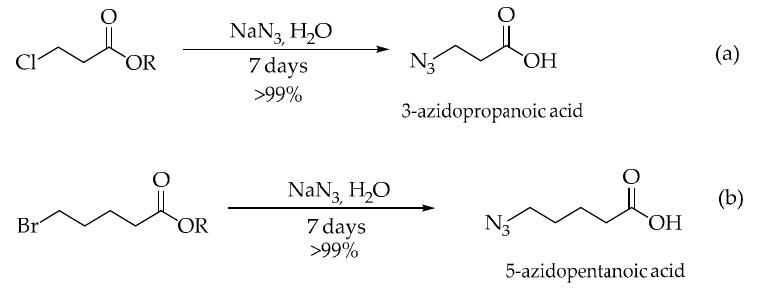
Figure 5. The synthesis of 3-azidopropanonic ( a ) acid and 5-azidopentanonic acid ( b ).